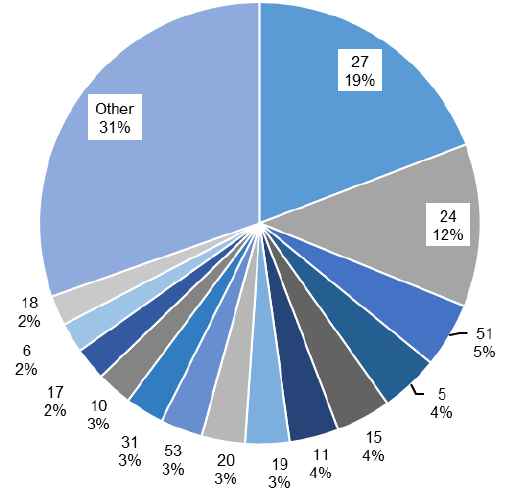
Figure 3. CO 2 emissions of each sector.